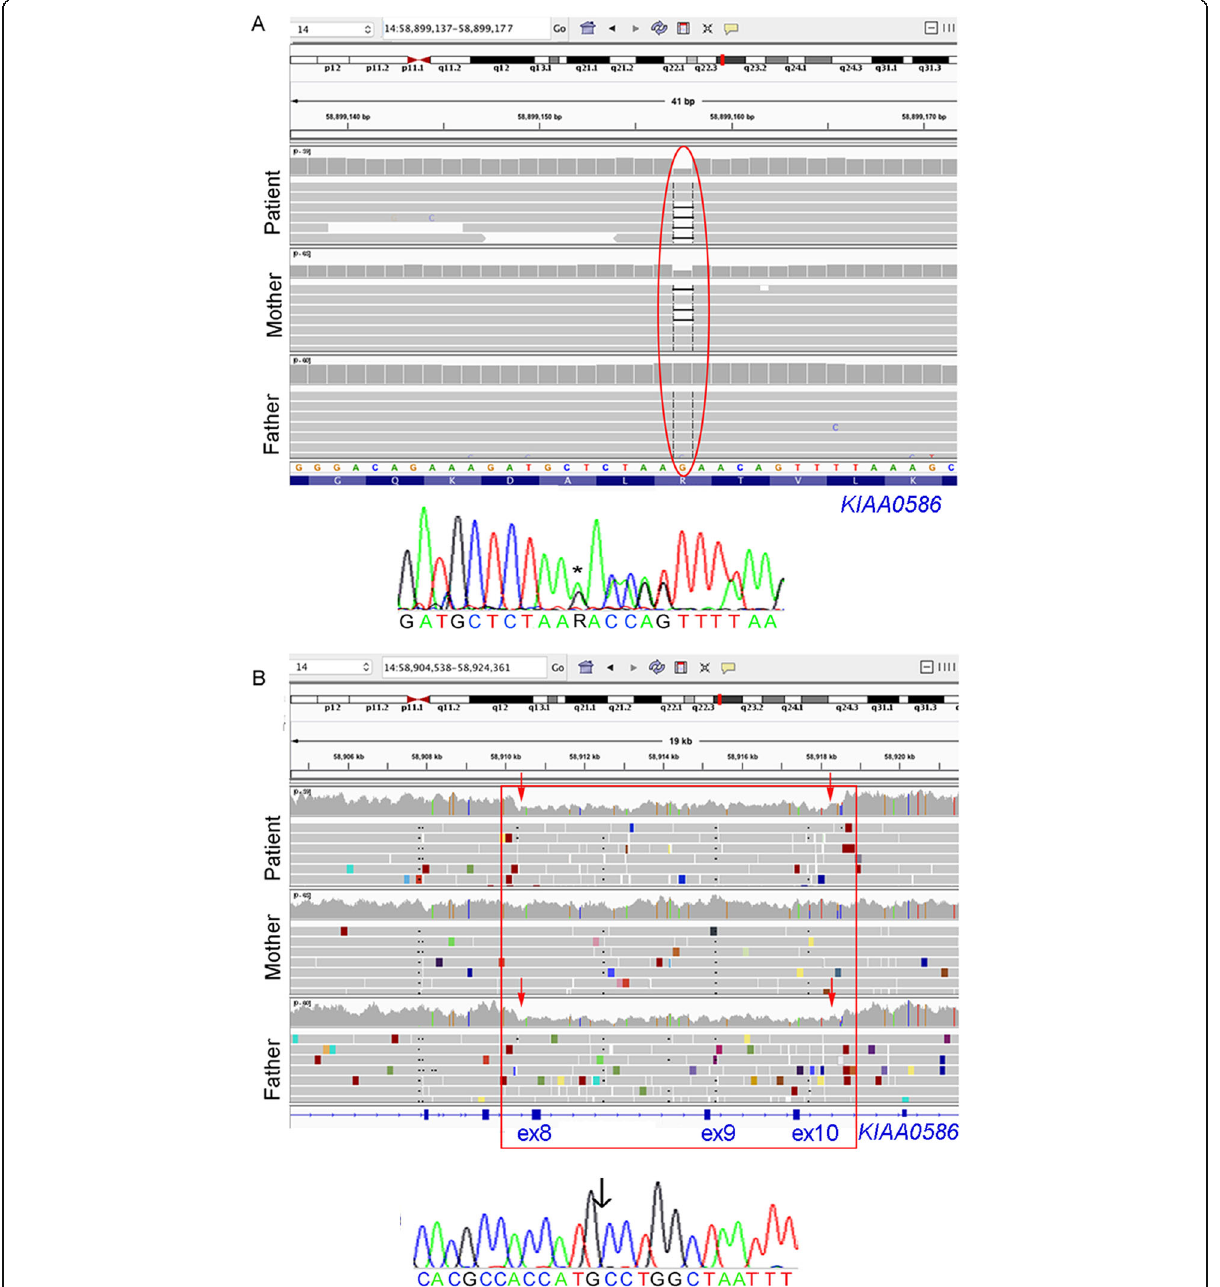
Fig. 3 a Upper. WGS data in Integrative Genome Viewer (IGV) (http://software.broadinstitute.org/software/igv) showing the heterozygous 1 bp deletion in KIAA0586 in the patient and his mother, but not in the father (red oval). Lower. Sanger sequencing on DNA from blood of the patient verifying 1 bp deletion in KIAA0586. R = A or G (as a consequence of the heterozygous deletion of G followed by A). b Upper. Screenshot from the IGV showing the 8.3 kb deletion in KIAA0586 detected in heterozygosity in the patient and his father, but not in the mother (red square) removing exons 8, 9 and 10 in KIAA0586 (blue boxes in the bottom). Note the decreased coverage in the deleted region in the patient and his father (red vertical arrows) and the reads with ends spanning the deletions (in red). Lower. Sanger sequencing of DNA from blood of the patient verified the 8.3 kb deletion in KIAA0586 and re-defined its breakpoints slightly to chr14 (GRCh37):g.58910301 –